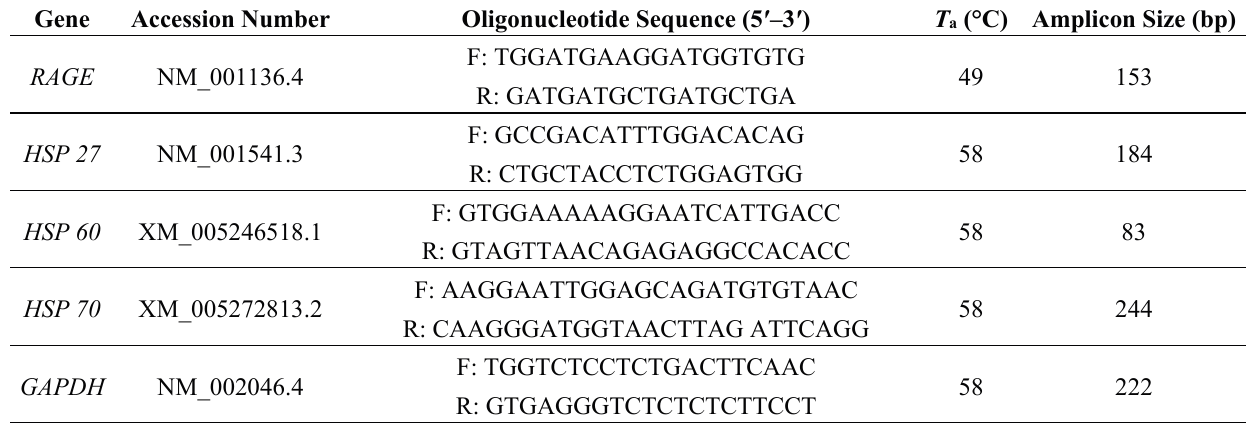
Table 2. The target genes and the primer sequences used for real-time